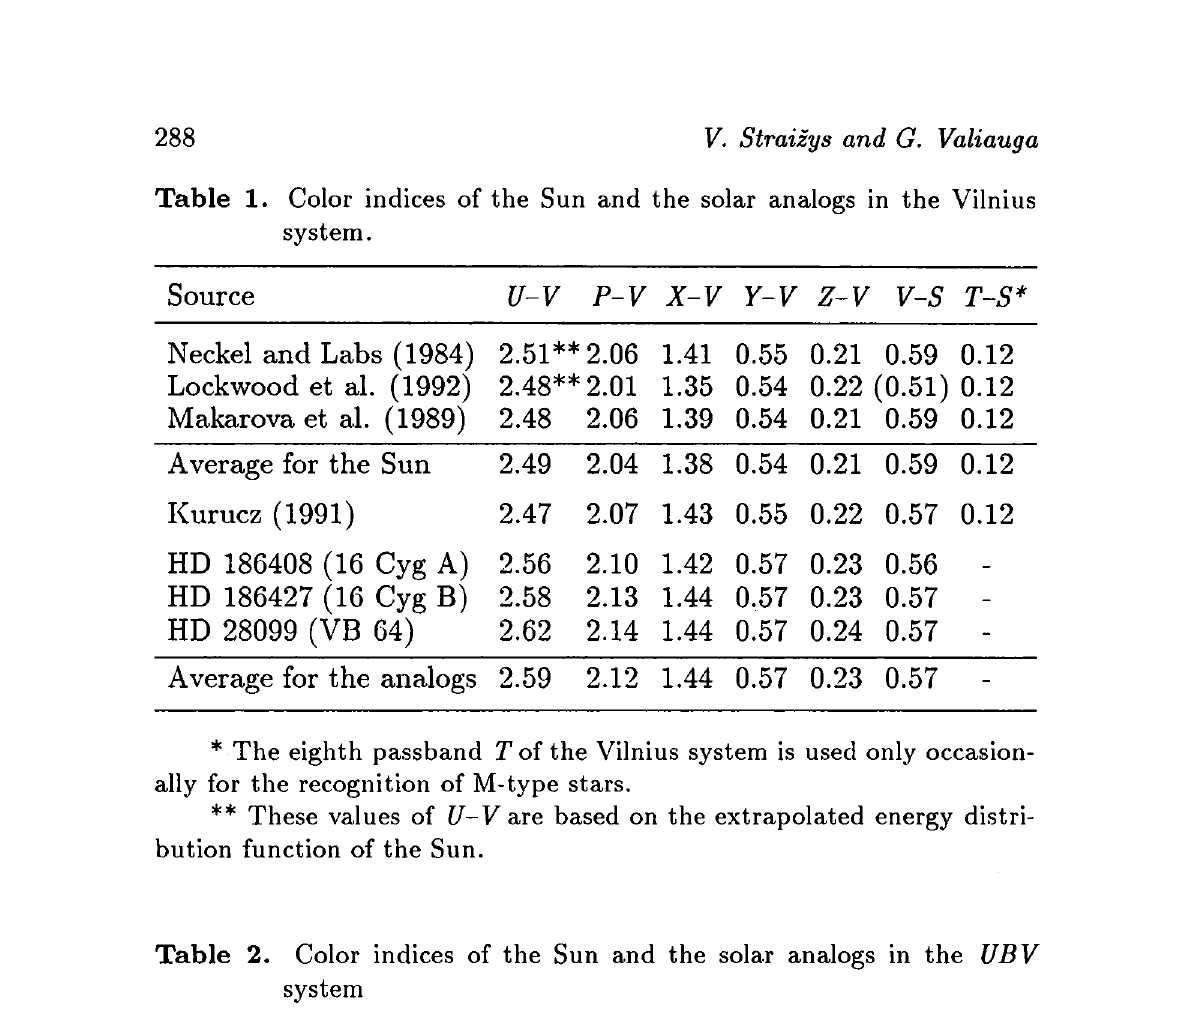
Table 2. Color indices of the Sun and the solar analogs in the